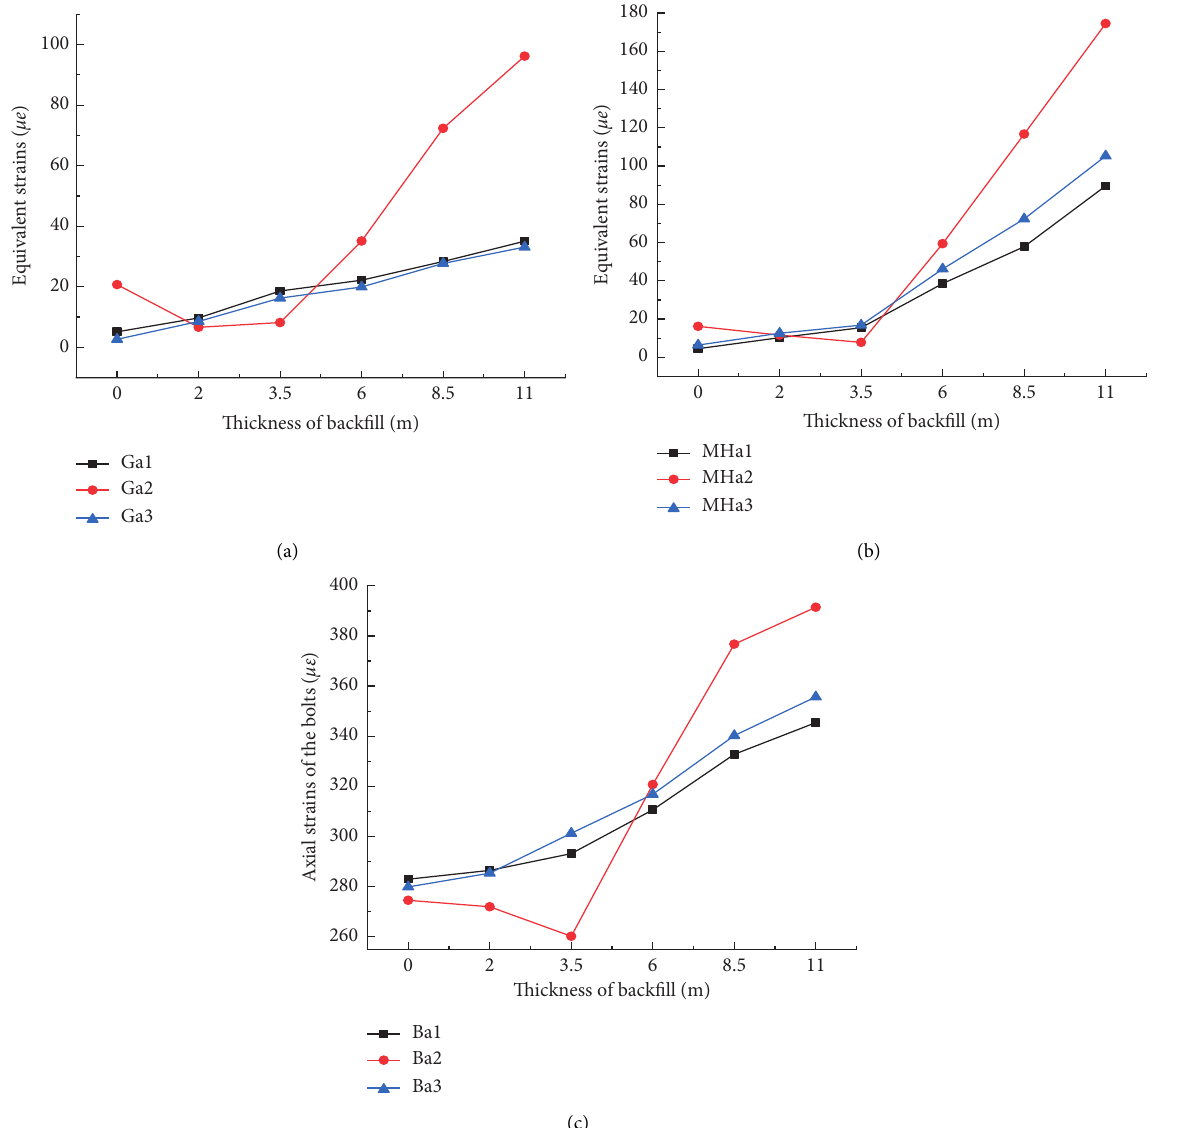
Figure 5: Statistics of monitoring results. (a) Equivalent strain of concrete at the monitoring point of the tunnel’s inner wall. (b) Equivalent strain of concrete at the monitoring point behind the bolt groove. (c) Strain of connecting bolts between tube